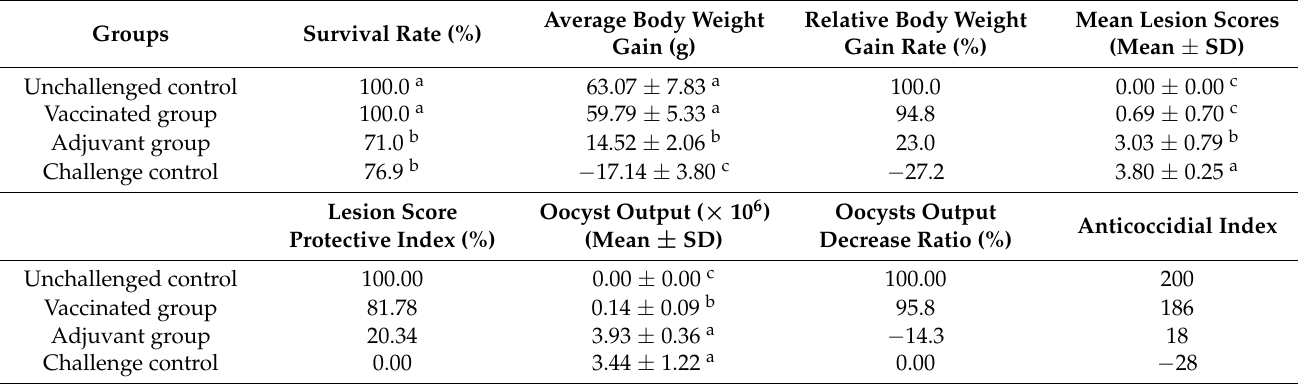
Table 1. Effects of E. tenella whole sporozoite vaccine immunization on the 1st and 10th days of age against a challenge at 21st days of age with 30,000 sporulated oocysts of a wild-type E. tenella strain on the parameters of immune protection.